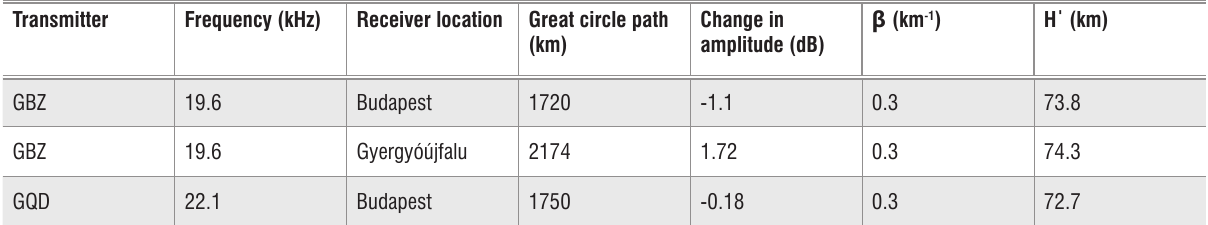
Transmitter frequencies and locations with transmission path distances from transmitter to receiver and changes in very low frequency amplitude observed during the solar flare on 13 December 2007. The modelled values of the reflection height ( H ˈ ) and the sharpness parameter ( β ) were obtained from the Long Wave Propagation Capability